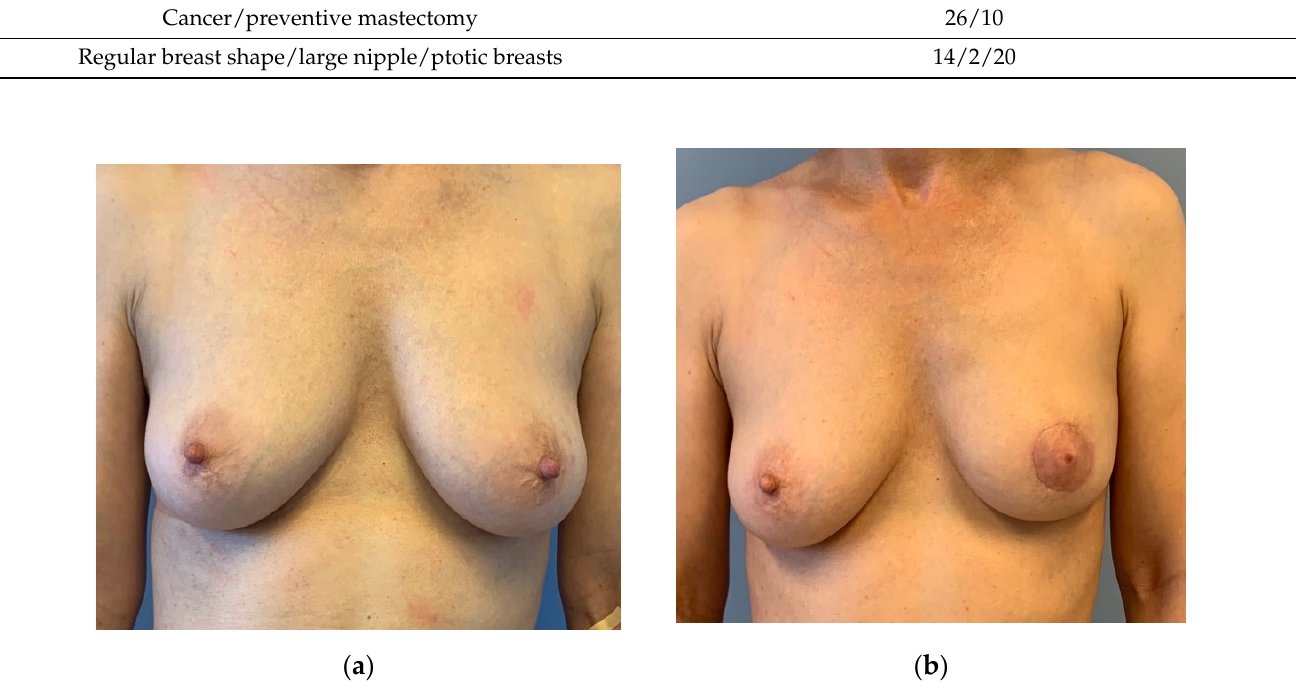
Figure 5. ( a ) Preoperative: 51-year-old patient with a multicentric invasive cancer on the left side and a large DCIS. Patient underwent neoadjuvant chemotherapy. Mild ptosis. ( b ) Three months after circumareolar mastectomy, inner thigh flap and free NAC graft (histologically controlled). Mastectomy weight and flap weight were almost identical. Circumareolar skin was resected at the lower pole to reduce the length of the nipple to IMF distance. An alignment of the right breast was not desired. No other scar at the breast apart from the periareaolar.